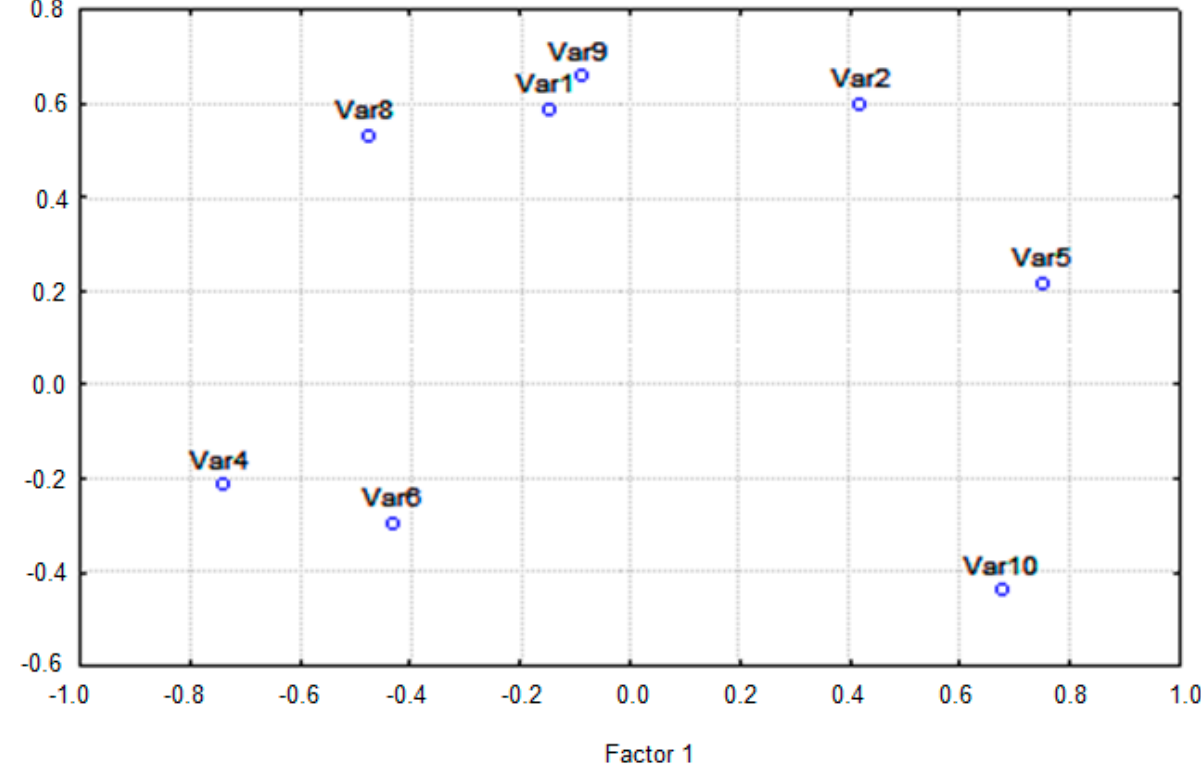
Figure 4. Factor scores of the analyzed amniotic fluid samples. BPS (Var1), BPF (Var2), BPE (Var3),